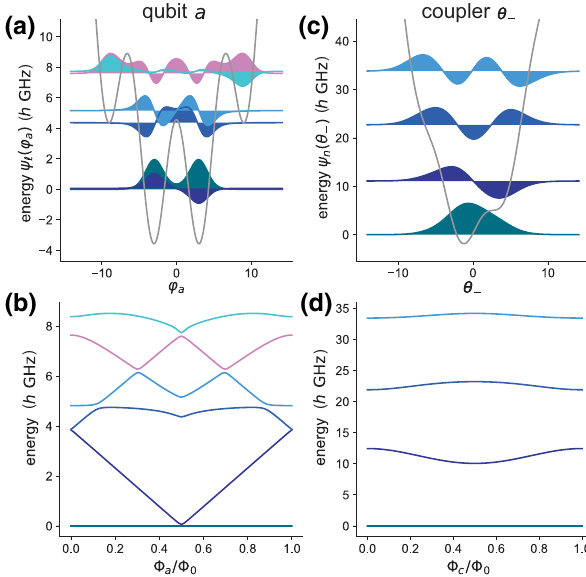
FIG. 2. Bare wave functions and energy spectra. (a) The bare wave functions and potential of qubit a , located at the half-flux sweet spot. The bare-qubit transition frequency is ω a / 2 π = 62 MHz, while the energy of the next excited state is 4.3 h GHz above the energy of the first-excited state. (b) The spectrum of qubit a as a function of the qubit flux (cid:3) a . The wave functions and spectra of qubit b are qualitatively similar to those of qubit a . (c) The bare wave functions and potential of the coupler θ − mode, located at (cid:3) c /(cid:3) 0 = 0.27. The energy of the first excited state is more than 10 h GHz above the coupler ground-state energy. (d) The spectrum of the coupler θ − mode as a function of the coupler flux φ c . See Table I for device parameters as well as Table II for a summary of the frequencies and anharmonicities of the bare modes.